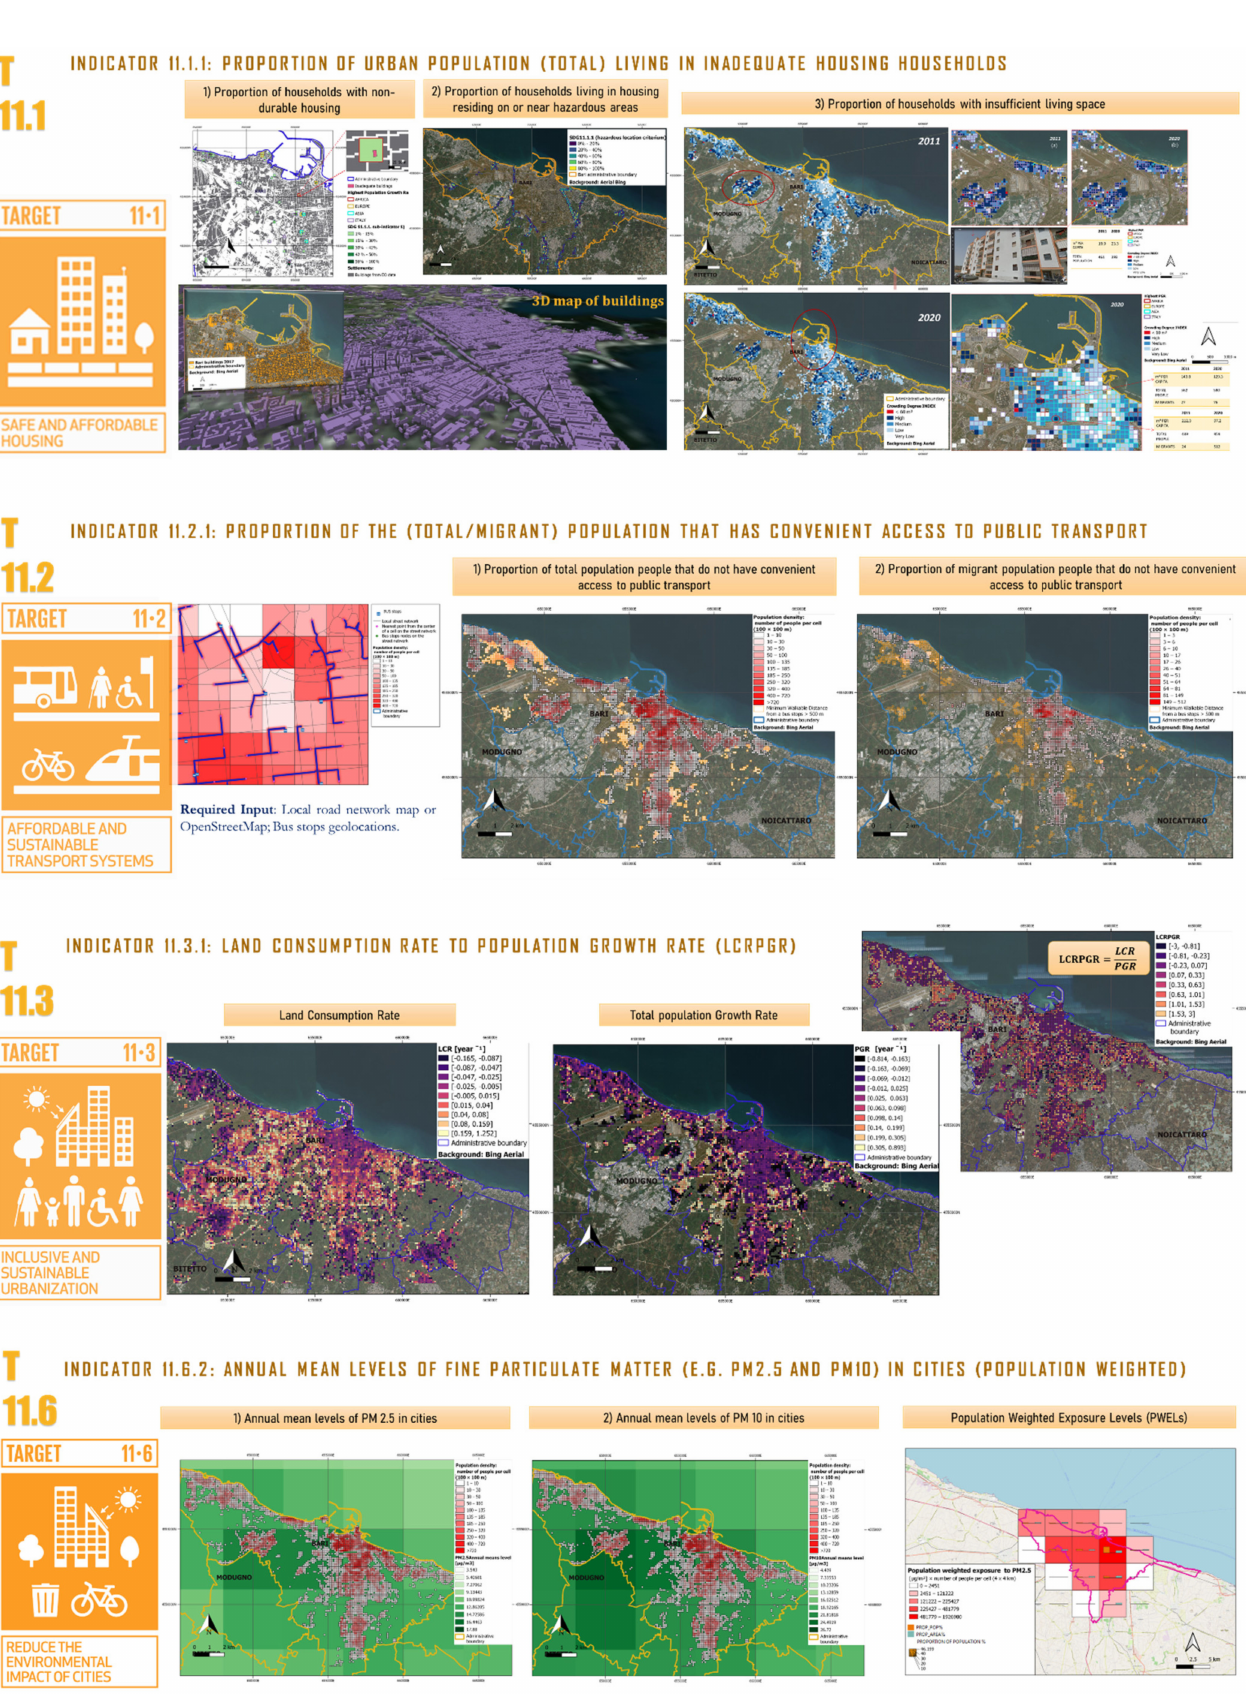
Figure 6. Summary of all SDG11 indicators computed for Bari city in